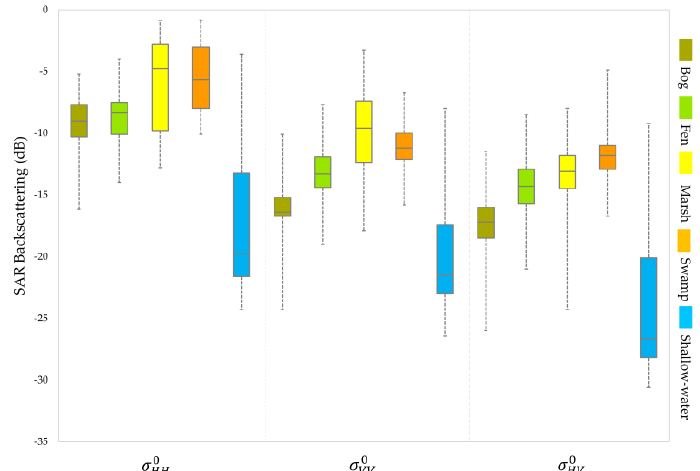
Figure 3. Box-and-whisker plots demonstrating the distribution of the SAR backscattering coefficients of FP SAR data for wetland classes obtained from the pixel values of the training data set. Note that the horizontal bars within boxes indicate median values, boxes illustrate the lower and upper quartiles, and whiskers range from minimum to maximum values.